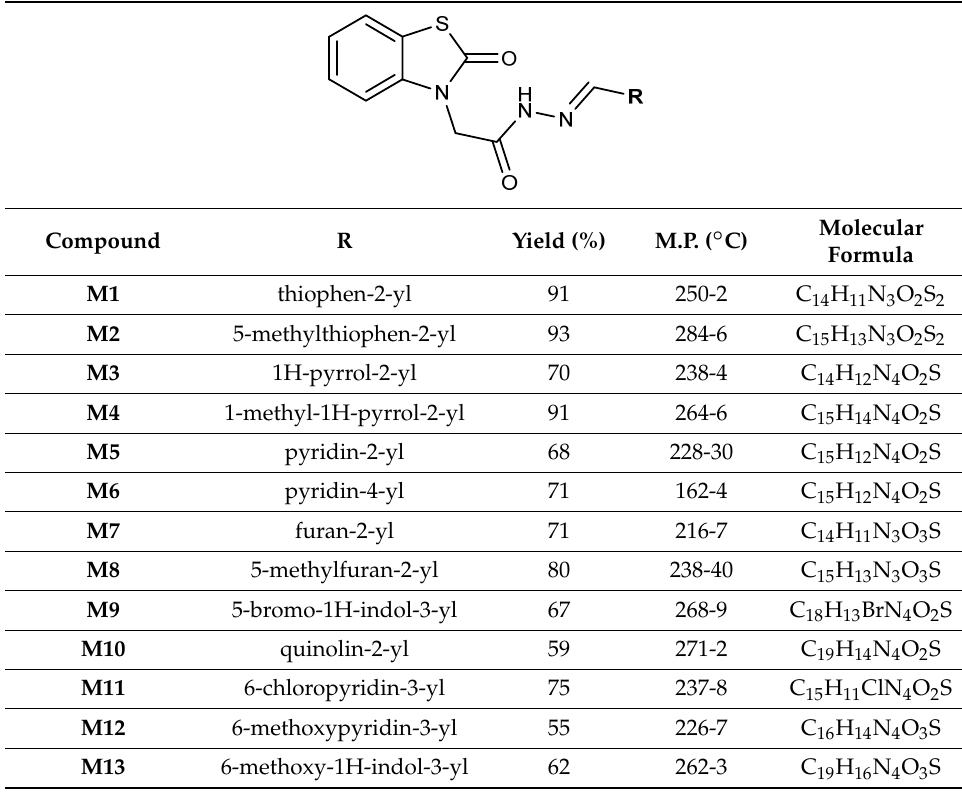
Table 1. Structures, yields, melting points, and molecular formula of the synthesized compounds.